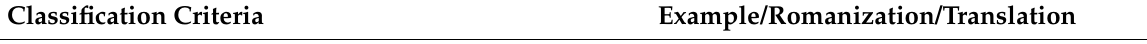
Table 2. Definition of primary information with examples from election tweets.